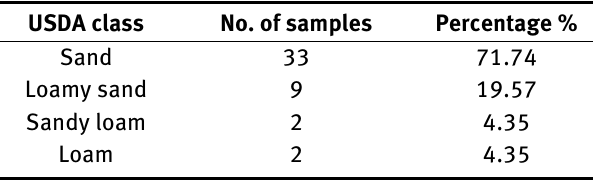
Table 3: USDA soil classification for Tigris River bed samples [26].